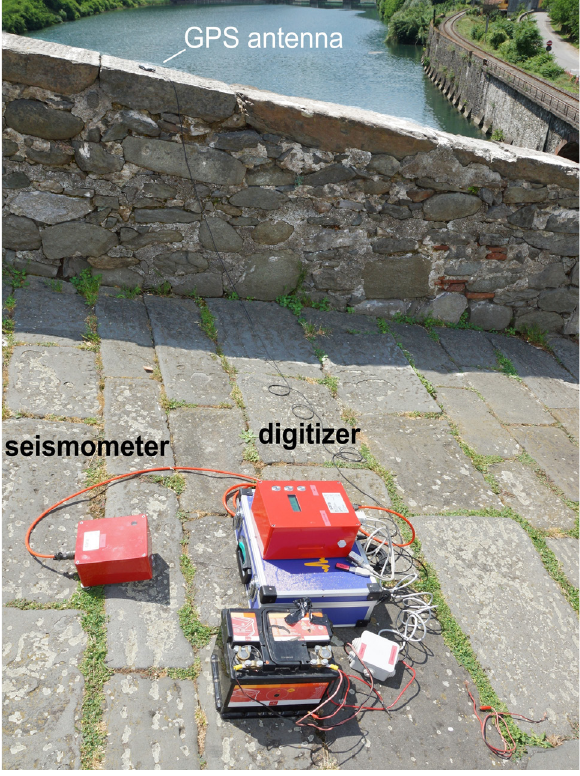
Figure 5. Seismometric station on the bridge road surface during Test